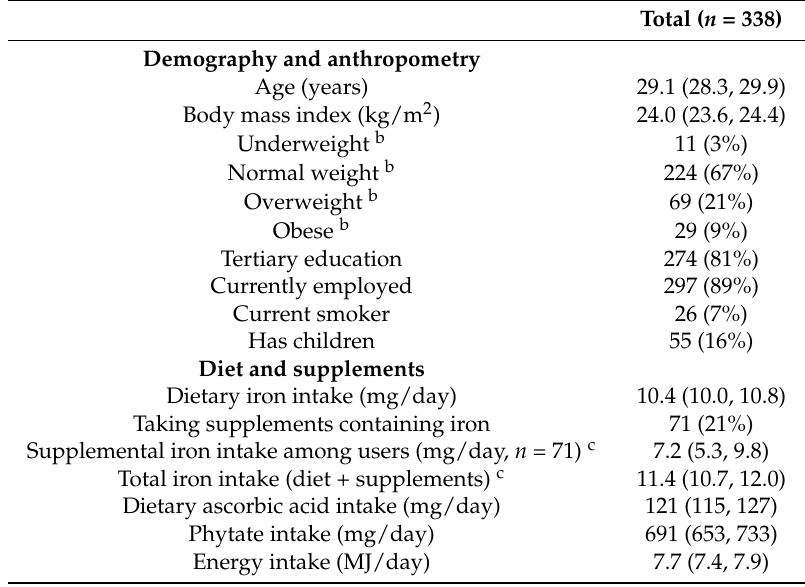
Table 1. Characteristics of the study sample of premenopausal women aged 18–50 years a